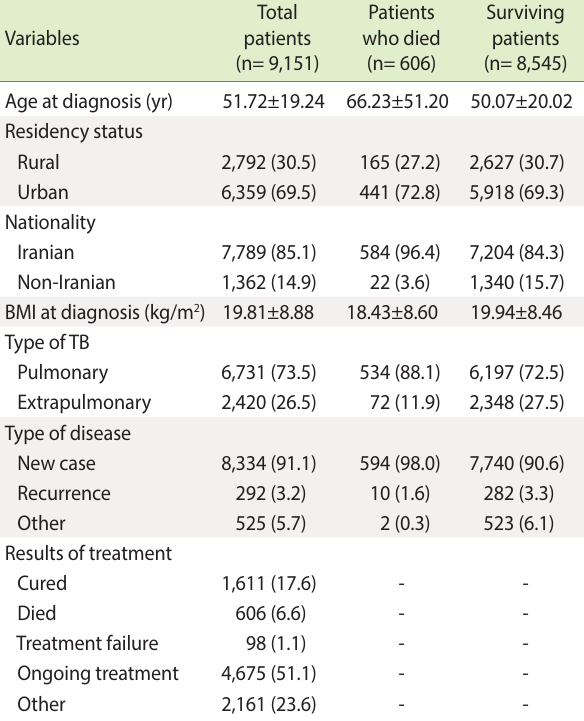
Table 1. Descriptive statistics of study variables among all TB pa-